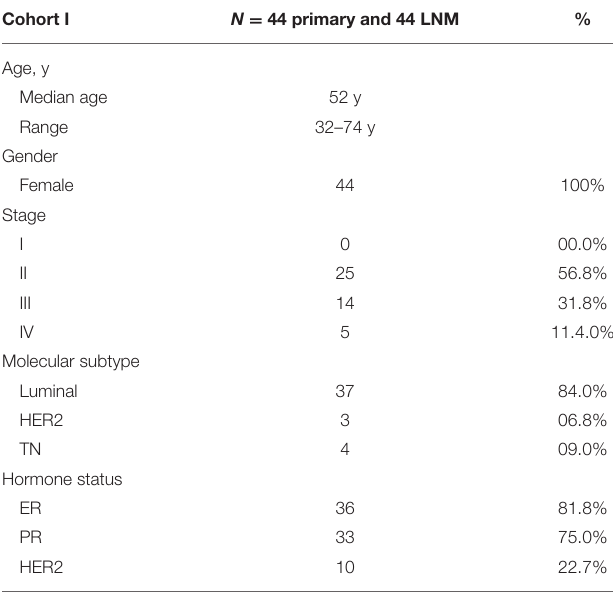
TABLE 1 | Clinical information of patients included in current study and their tumor